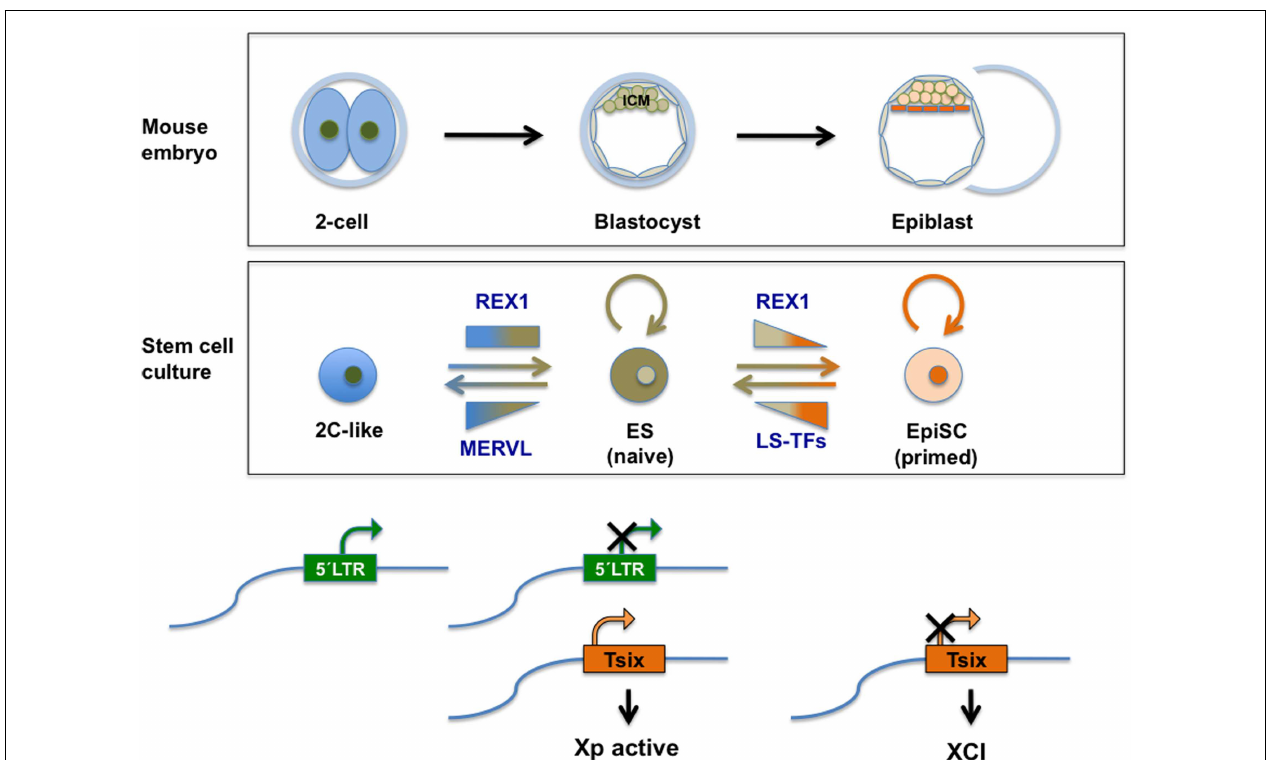
these cellular transitions. REX1 is present throughout pre-implantation development ( Figure 2 ) and regulates MERVL and Zscan4 expression at these stages.Therefore a function of REX1 in the transition between totipotent 2C-like and pluripotent ES cells is speculated on (see text). Levels of Zfp42 are not significantly affected in 2C-like cells (17). On the other hand, REX1 positively affects re-activation of the inactive X-chromosome typical of the ICM and naive ES cells, by promoting the transcription ofTsix. Bottom panel: LTR regulation.The LTR drives expression of MERVL and totipotency-specific gene expression in 2C-like cells with totipotent characteristics, which co-exist in culture with pluripotent REX1-expressing ES cells. REX1 silences MERVL in ES cells, and is necessary for full expression of Tsix . Tsix expression in turn is instrumental in both the re-activation of the paternal X-chromosome in the blastocyst, which is silenced at earlier stages and maintenance of re-activation compatible with naive pluripotency. In primed ES cells and in EpiSC Tsix is silenced and XCI is installed. LS-TFs, lineage specific transcription factors expressed in primed ES cells and EpiSC; Xp, paternally derived X-chromosome XCI; X-chromosome inactivation;Tsix, lncRNA counteracting XCI,